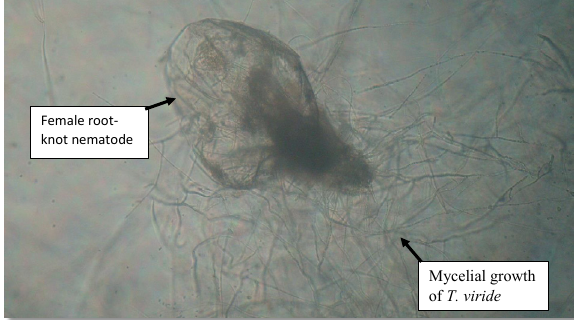
Figure 1c: Parasitism of T. viride on female of root-knot nematode, M. incognita ×100